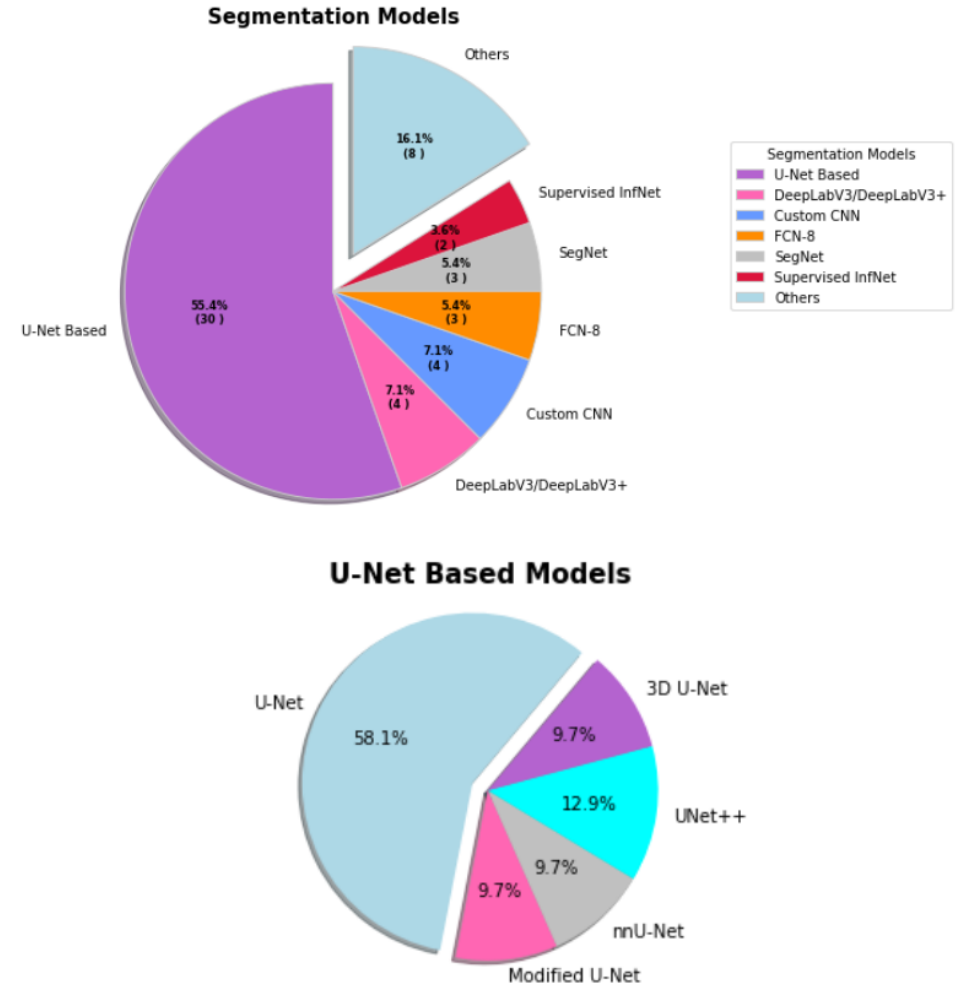
Figure 7. The percentages of segmentation models applied for